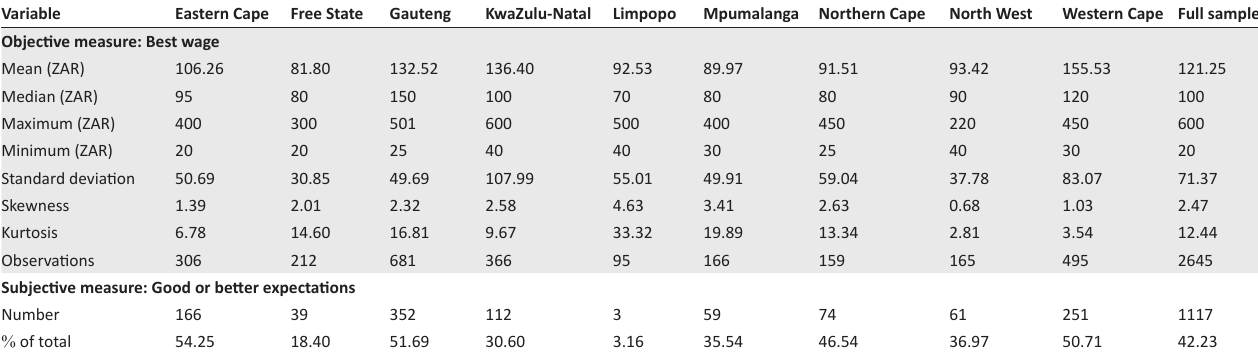
TABLE 6: Descriptive statistics for the dependent variables. Variable